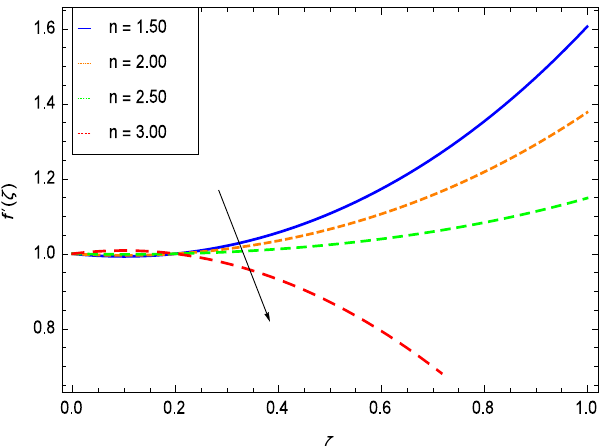
Figure 8. Flow layer at h = − 3.00, β = 0.10, φ = 0.40, M = 2.00, We = 0.50, S = 0.50, A = π enhancement in n .